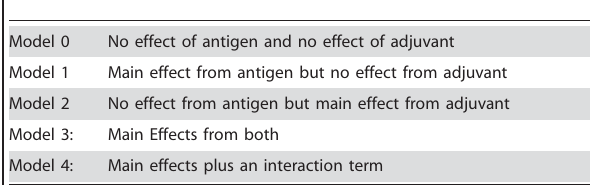
Table 5. Cumulative Logit Models used to Evaluate the Relationship between Treatment Outcome and Adjuvant and Antigen